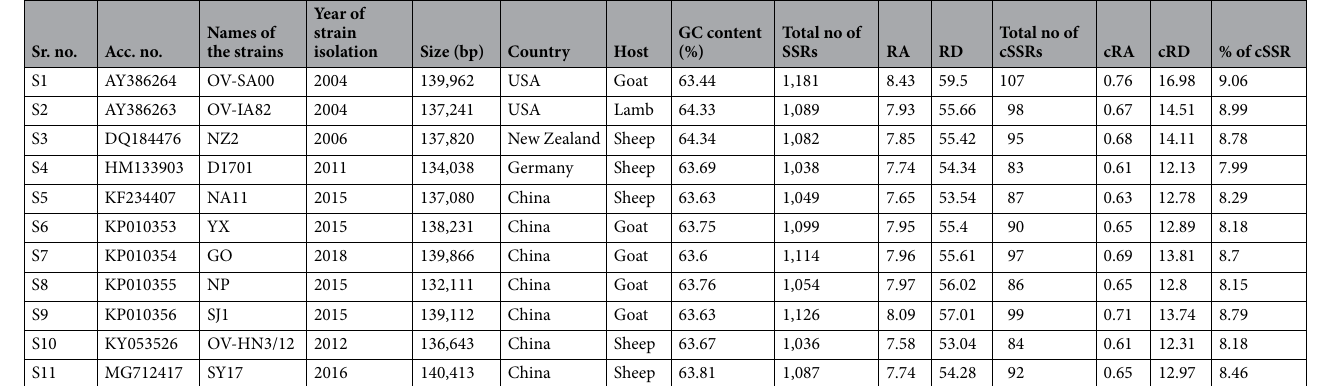
Materials and methods